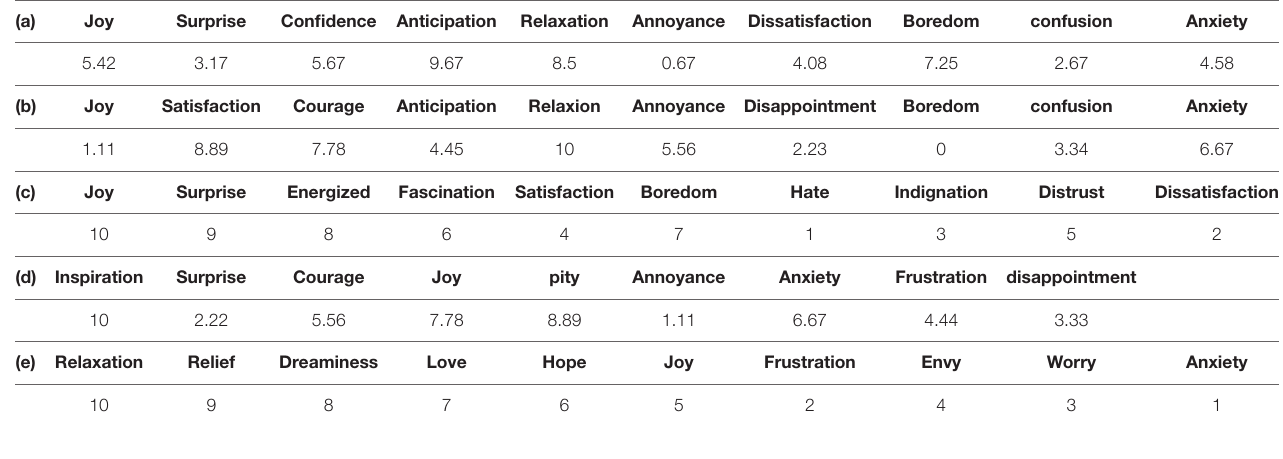
TABLE 4 | Multi-factor experimental emotion value